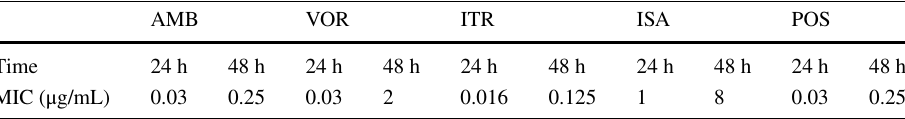
antifungal susceptibility of E. rostratum isolates using European Committee on Antimicrobial Susceptibility Testing (EUCAST)